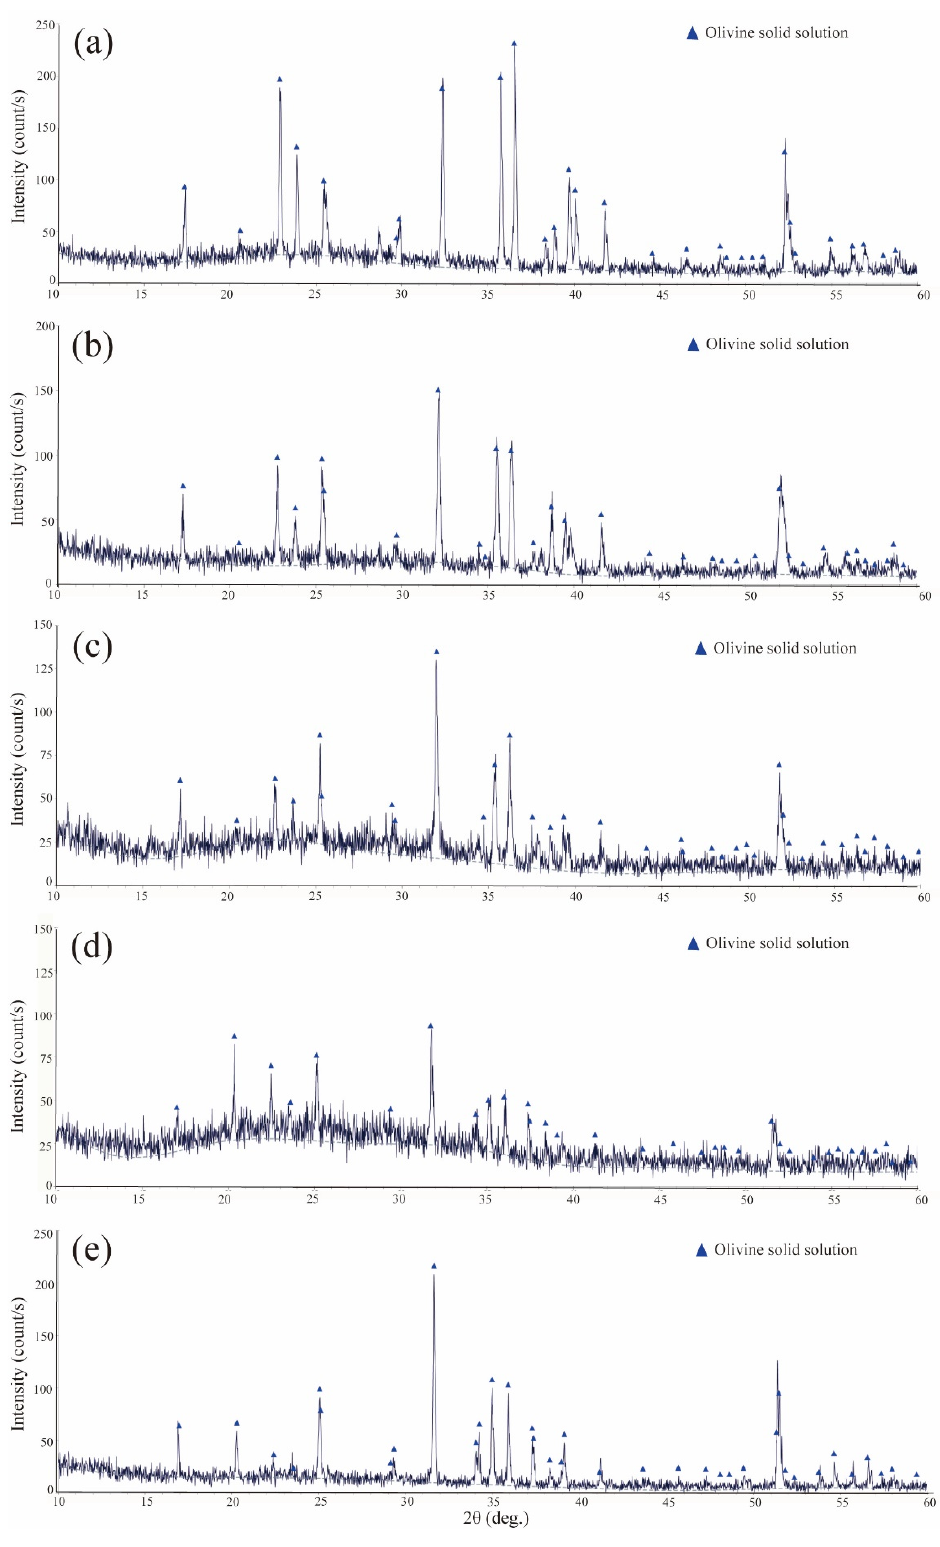
Figure 1. Powder X-ray diffraction patterns of synthesized olivine solid solutions: ( a ) Fo 100 -3, ( b